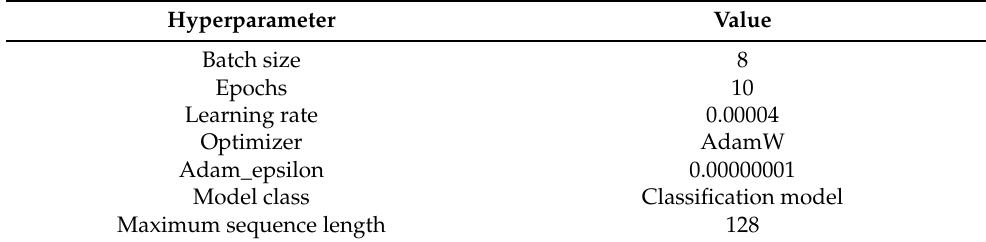
Table 1. Hyperparameters of the fine-tuned